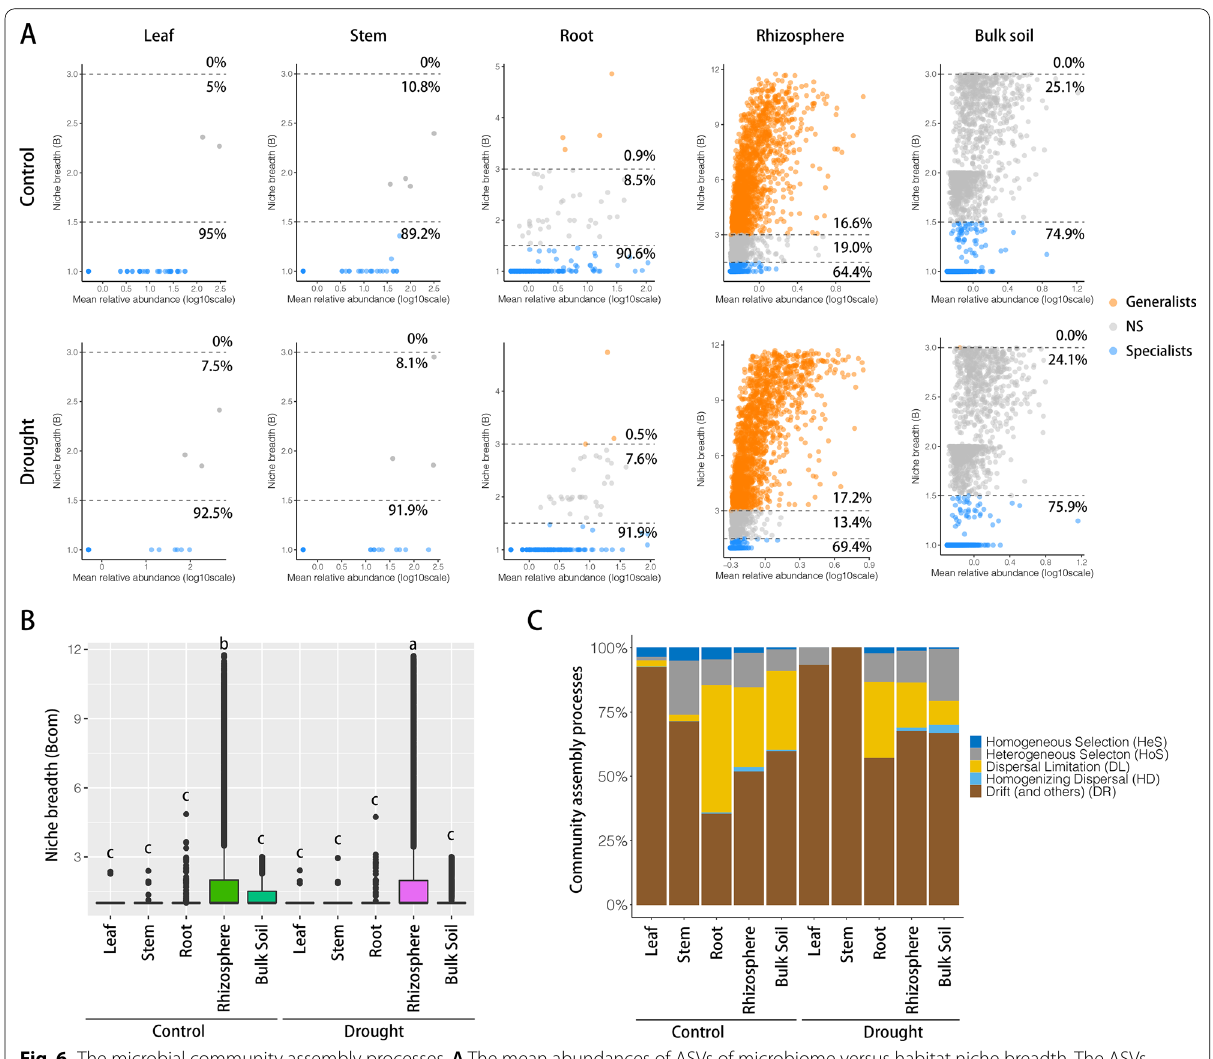
Fig. 6 The microbial community assembly processes. A The mean abundances of ASVs of microbiome versus habitat niche breadth. The ASVs of temporal generalists are colored orange, the ASVs of specialists are colored blue. B Boxplots illustrating mean habitat niche breadth (Bcom). Significant differences (Kruskal–Wallis test, p < 0.05) are indicated by different letters. C The percentage of turnover in the leaf, stem, root, rhizosphere and bulk soil microbial communities under control and drought stress, governed by deterministic processes (homogeneous and heterogeneous selection), stochastic processes (dispersal limitation, homogenizing dispersal and